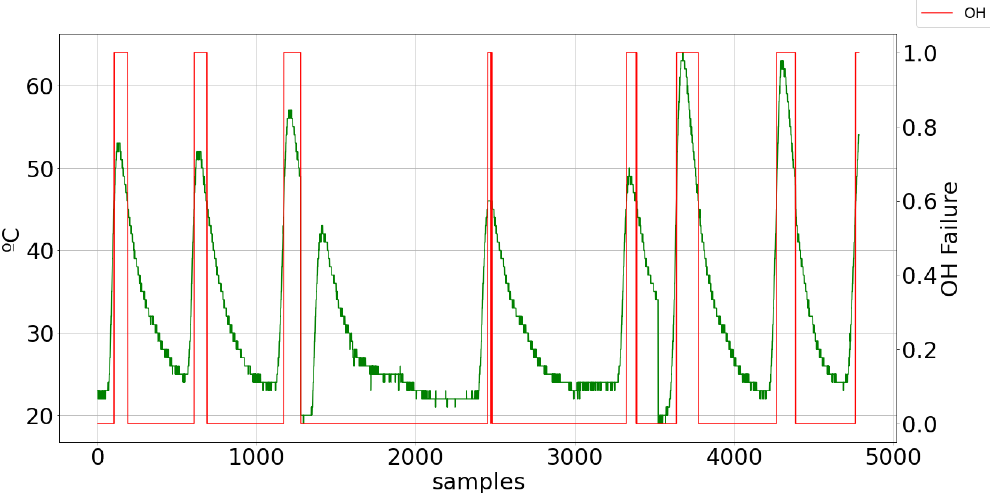
Figure 11. The OH failure is present in the ESC experiments. If the cell’s temperature is higher than 45 ◦ C, an OH failure is considered. The cell’s temperature does not increase in the same proportions as found in OC and